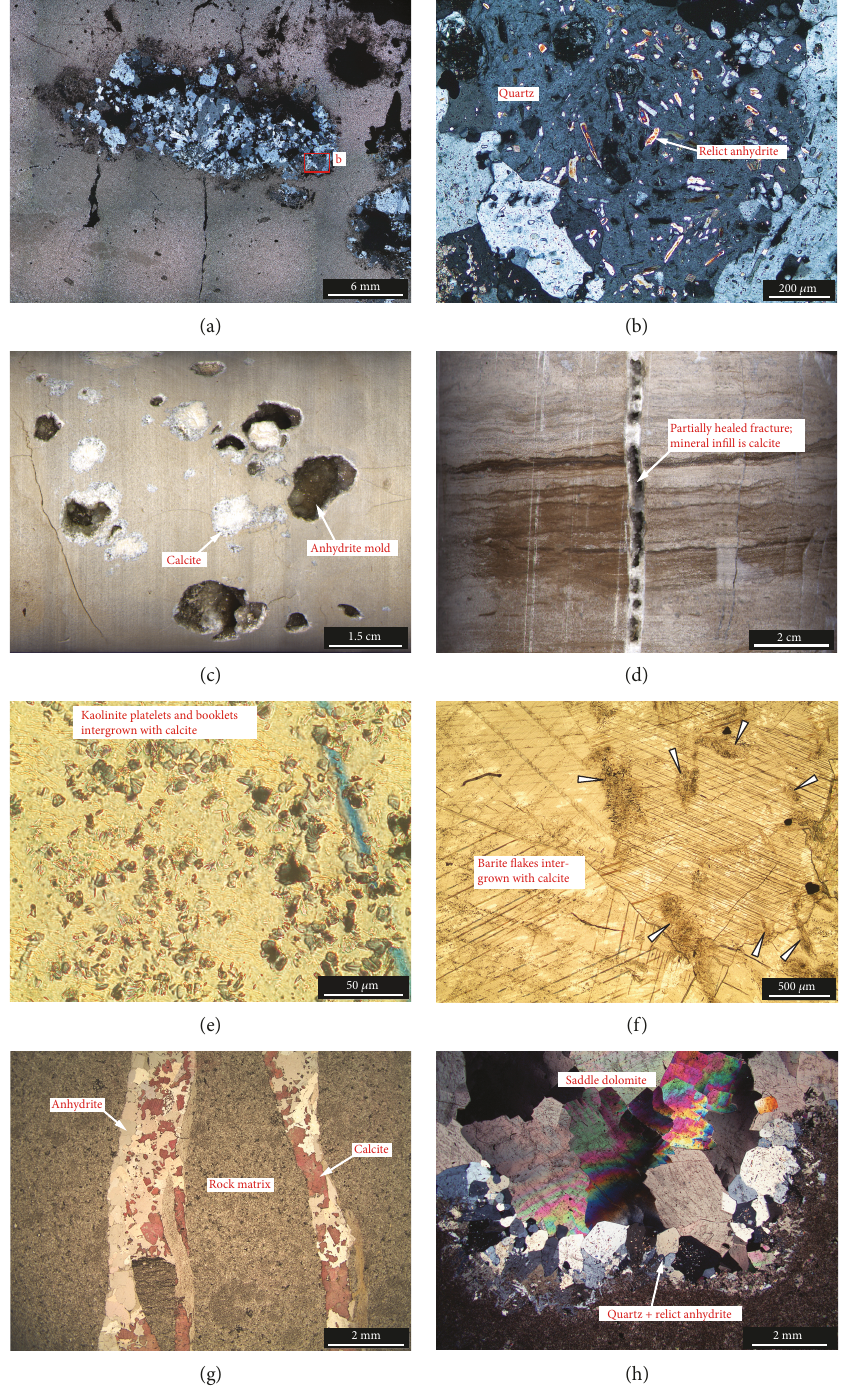
Figure 7: (a) Secondary quartz fi lling an anhydrite mould in the Trigonodus Dolomit (BEN 825.11m). (b) The quartz contains tiny, distributed inclusions of pyrite and relict anhydrite, indicating that the quartz precipitated during anhydrite dissolution and thus is associated with the formation of the anhydrite-dissolution pores (BEN 825.11 m). (c) Second-stage calcite clogging anhydrite moulds in the Muschelkalk (BOZ 81.90m). (d) Calcite in fractures (SLA 1170.83m). (e) Intergrowths of kaolinite and calcite fi lling an anhydrite mould (SLA 1135.29m). (f) Intergrowths of barite (arrowheads) and calcite fi lling an anhydrite mould (SLA 1164.33m). (g) Anhydrite occasionally replaces calcite within moulds and fractures in the Muschelkalk (calcite stained with Alizarin Red; SLA 1123.83m). (h) Saddle dolomite fi lling anhydrite moulds in the deeply buried Muschelkalk. Saddle dolomite postdates secondary quartz and associated minerals (BER 2189.11m) (a, b, h: crossed-polarized, transmitted-light microscopy; e – g: plane polarized, transmitted-light microscopy; c, d: re fl ected-light photograph of drill